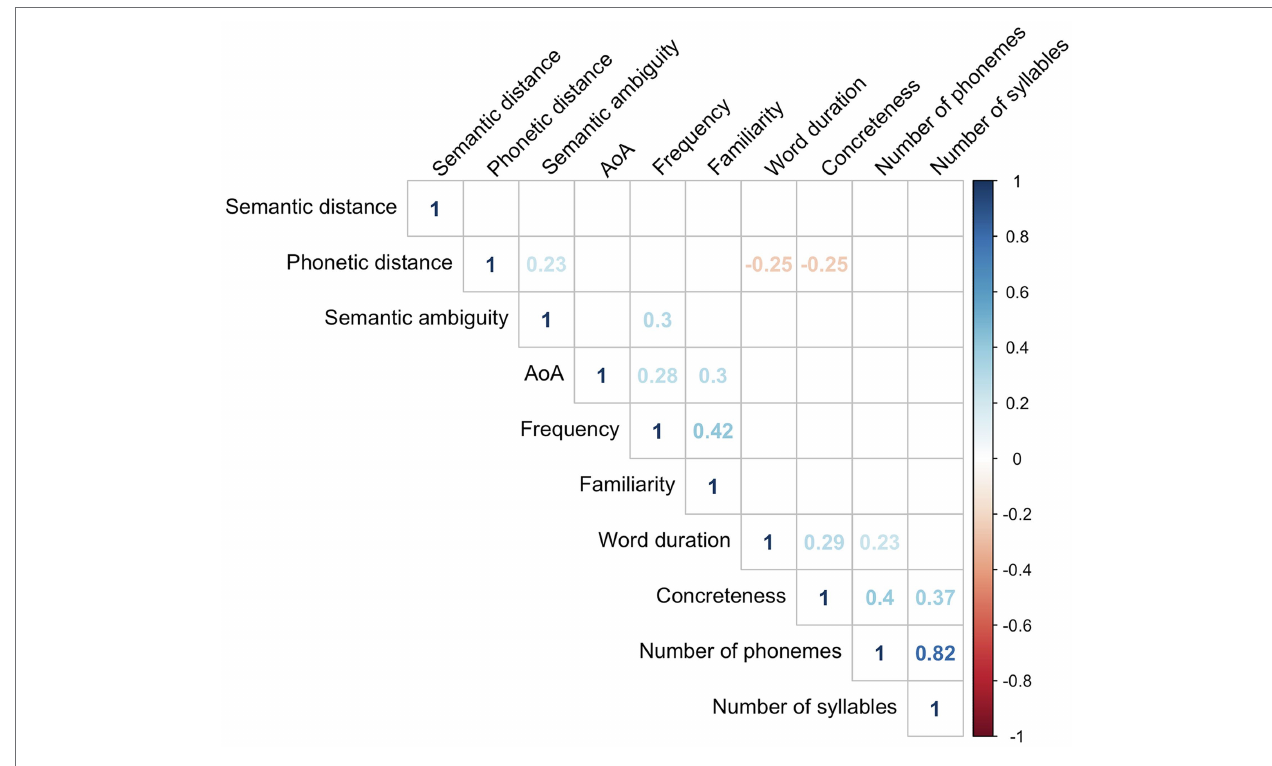
FIGURE 5 | The correlation matrix of the SD values of all variables. Only significant correlations ( p < 0.05) are shown in the figure.